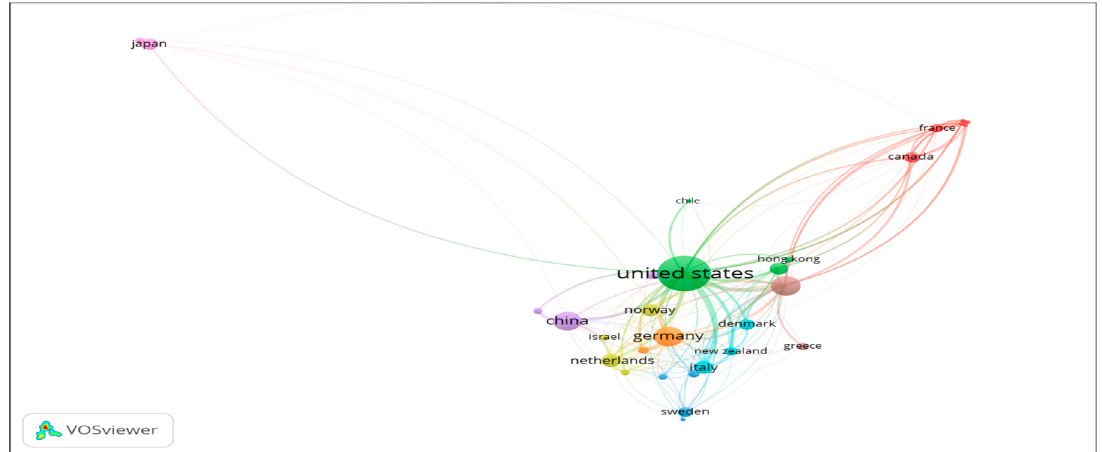
Figure 4. Visualisation Map of Top 20 Countries of Related Documents.